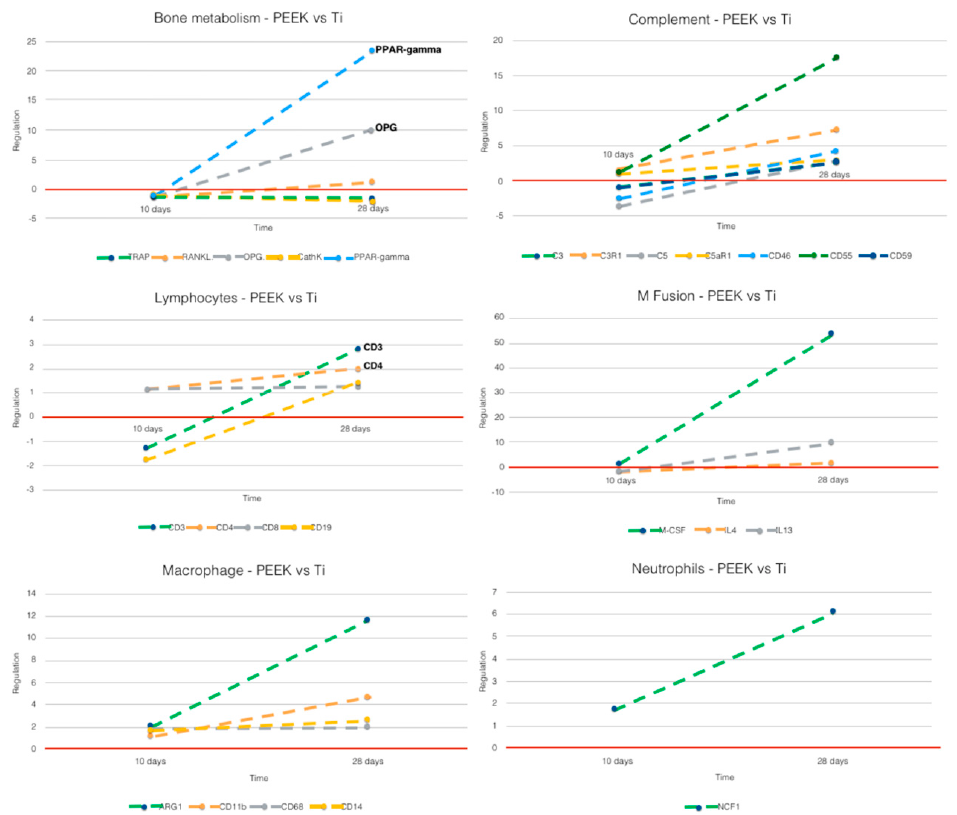
Figure 7. Comparative analysis of gene expression between 10 and 28 days for PEEK vs. Ti. Horizontal red line: zero regulation mark; x-axis: time; y-axis: gene marker regulation (10 or 28 days). Intermittent lines: do not represent actual results at time points other than 10 or 28 days, but only highlight trend from 10 to 28 days.